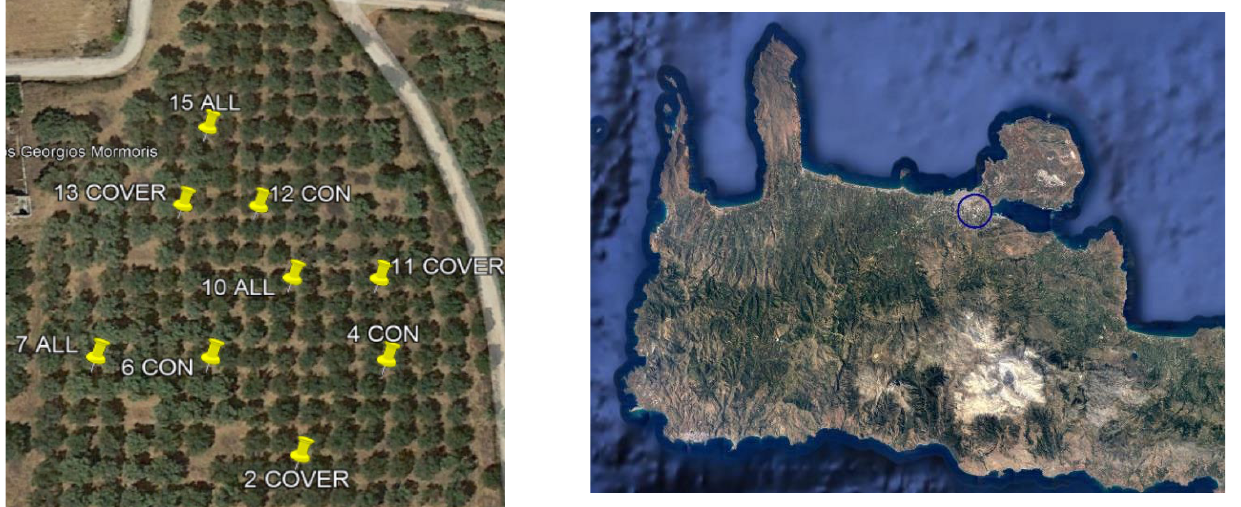
Figure 2. Experimental area and treatments of the olive grove in Western Crete. Maps based on Google Maps.